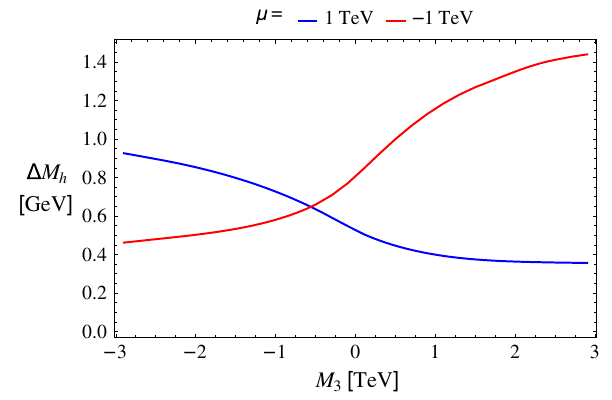
Fig. 5 Dependence of the lightest Higgs-mass shift (cid:7) M h on M 3 . The parameter μ is either positive (blue) or negative